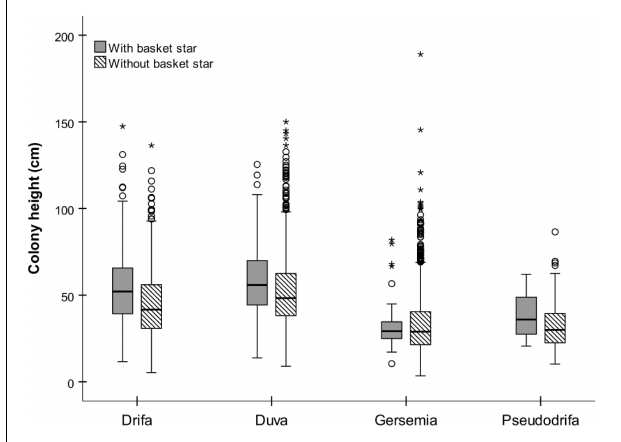
FIGURE 7 | Basket star presence-absence in relation to colony height by soft coral